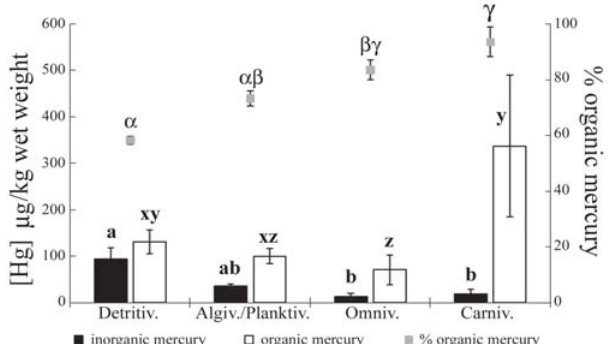
Fig. 2. Mean concentrations and ratios of mercury in muscle of fish collected from Vigário reservoir. Different letters indicate significant difference between groups: inorganic (ab) and organic mercury concentrations (xyz), and ratios of organic mercury ( αβγ ). Error bars represent the standard deviation of the mean.